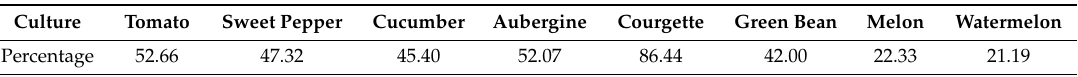
Table 3. Economic percentage weight of labor on current expenses of horticultural crops that occur in the southeast of Spain (Toresano and Camacho)